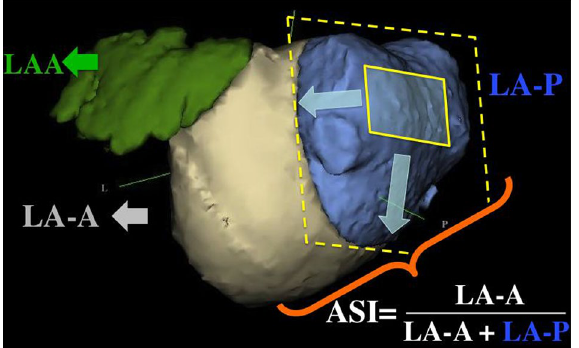
Figure 1. The asymmetry index (ASI) is the ratio LA-A/LAV. The division of LA volume (LAV) into anterior (LA-A) and posterior (LA-P) parts was defined by a cutting plane, between the pulmonary veins and the LA appendage (LAA) and parallel to the posterior wall 12